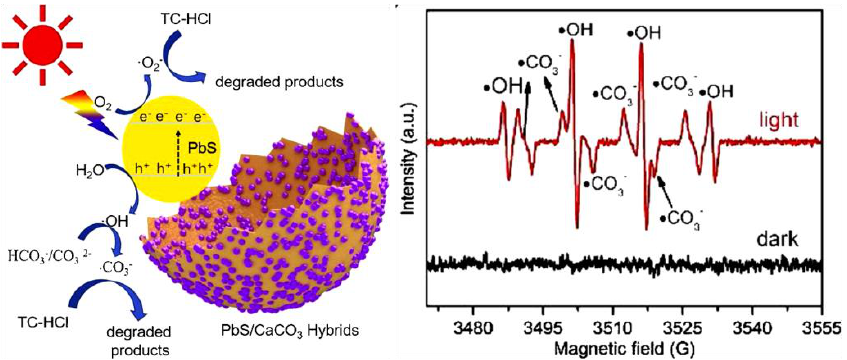
Figure 5. Photocatalytic degradation mechanism and radicals generation of PbS/CaCO 3 compo- sites